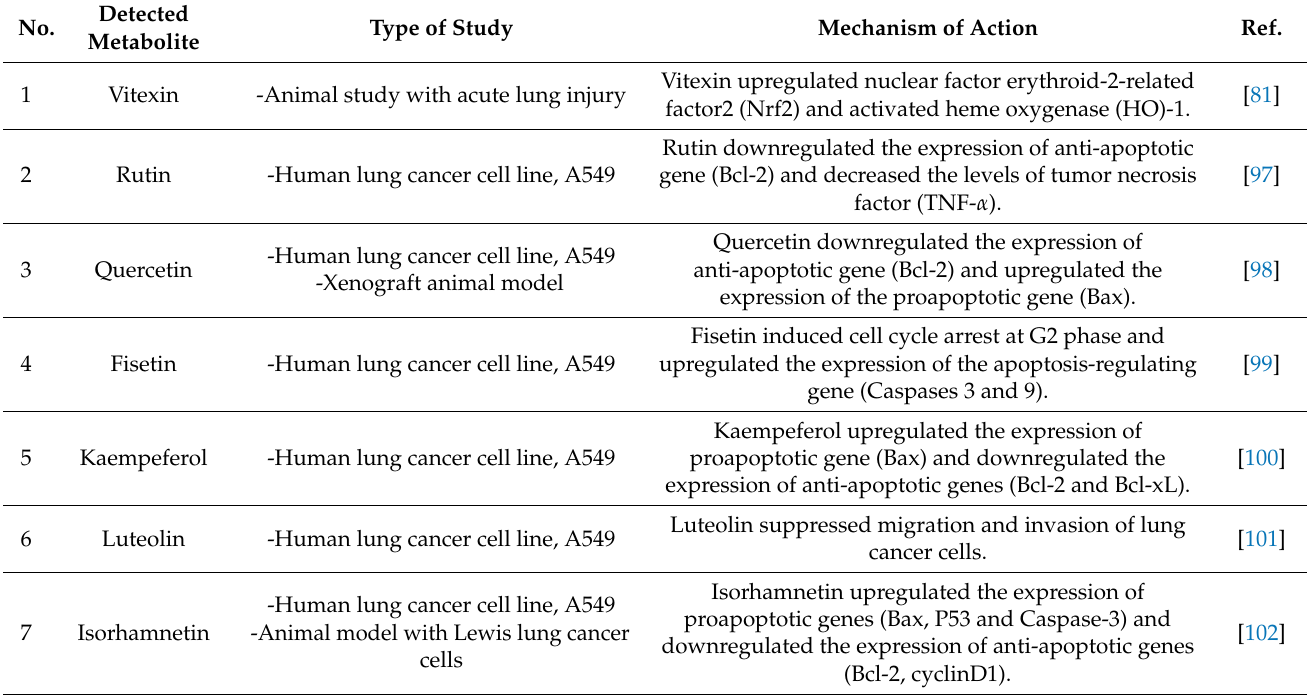
Table 4. The anti-lung cancer activity of some detected